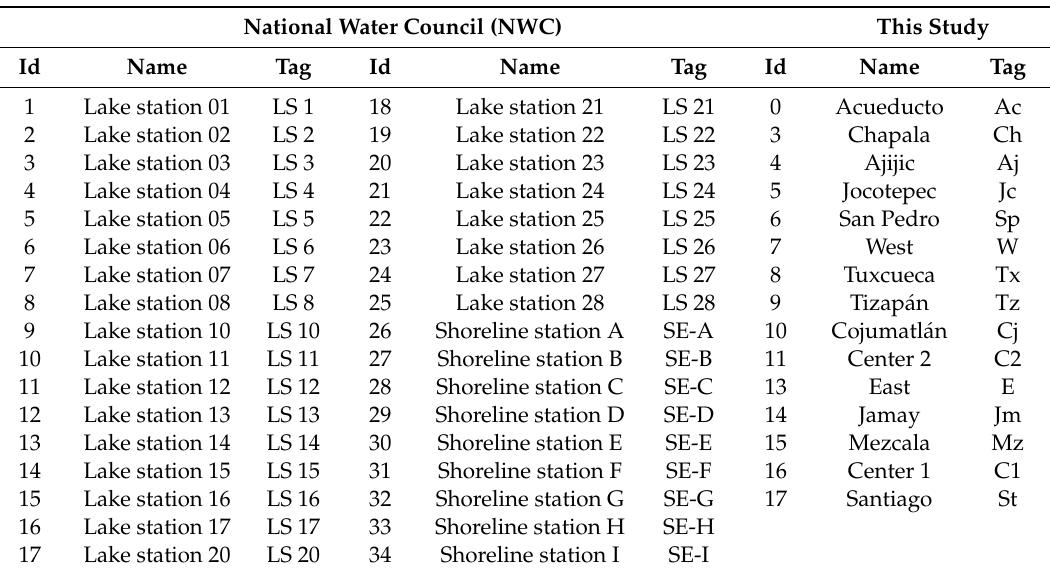
Table 1. Sampling sites in Lake